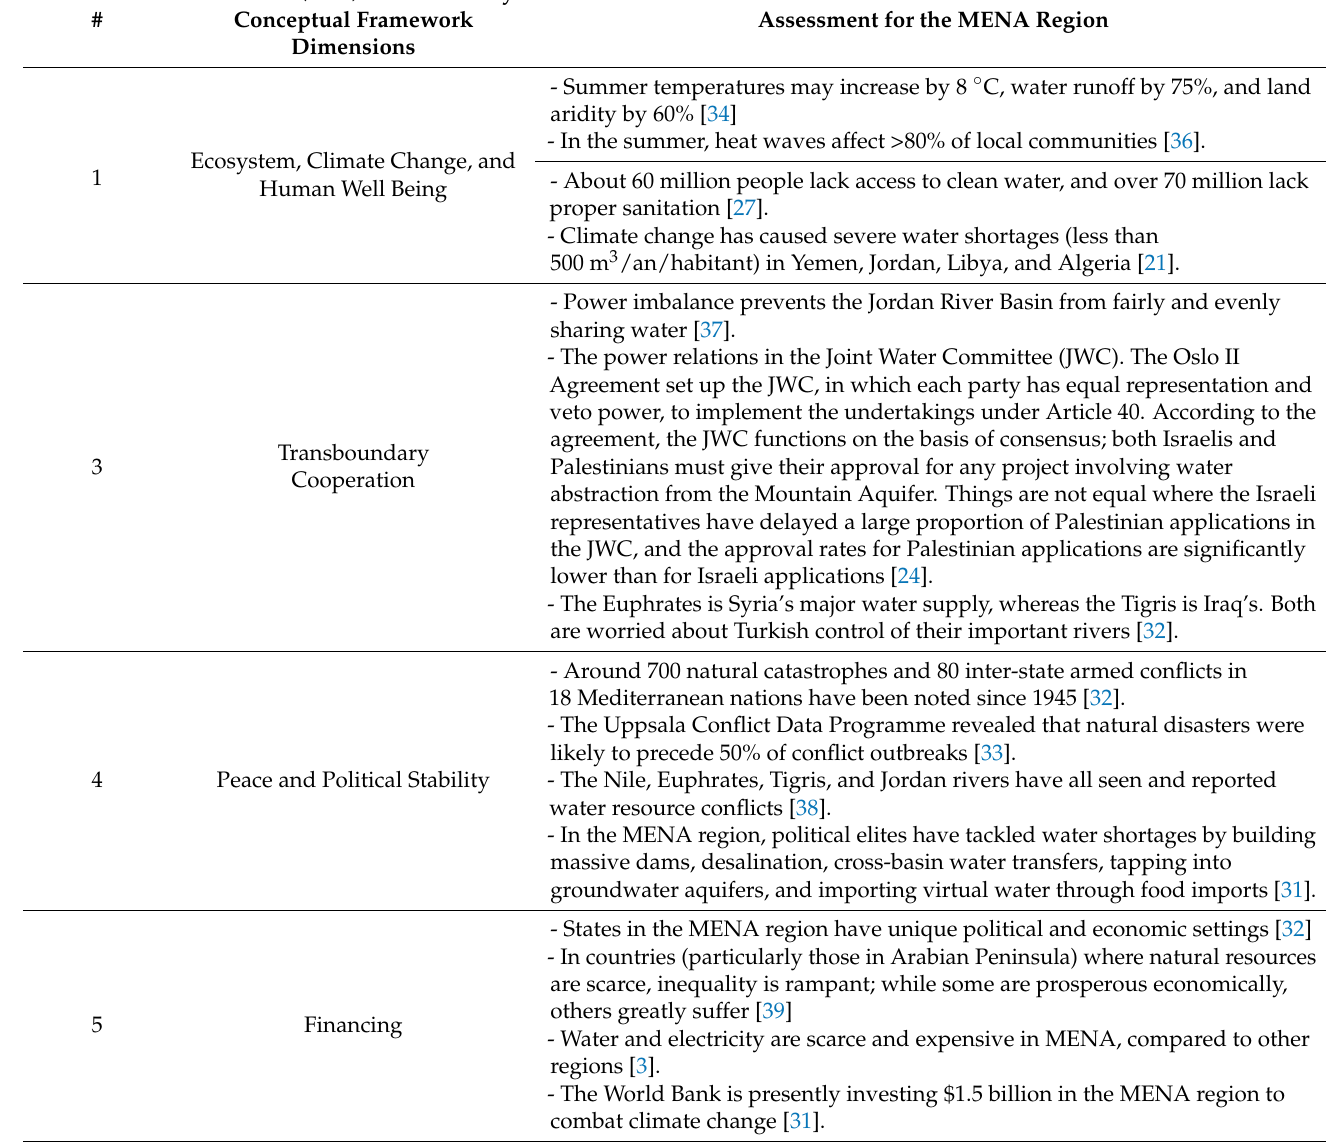
Table 1. Selected highlights about water security for the MENA region taking note of UN Water’s 2013 water security conceptual framework